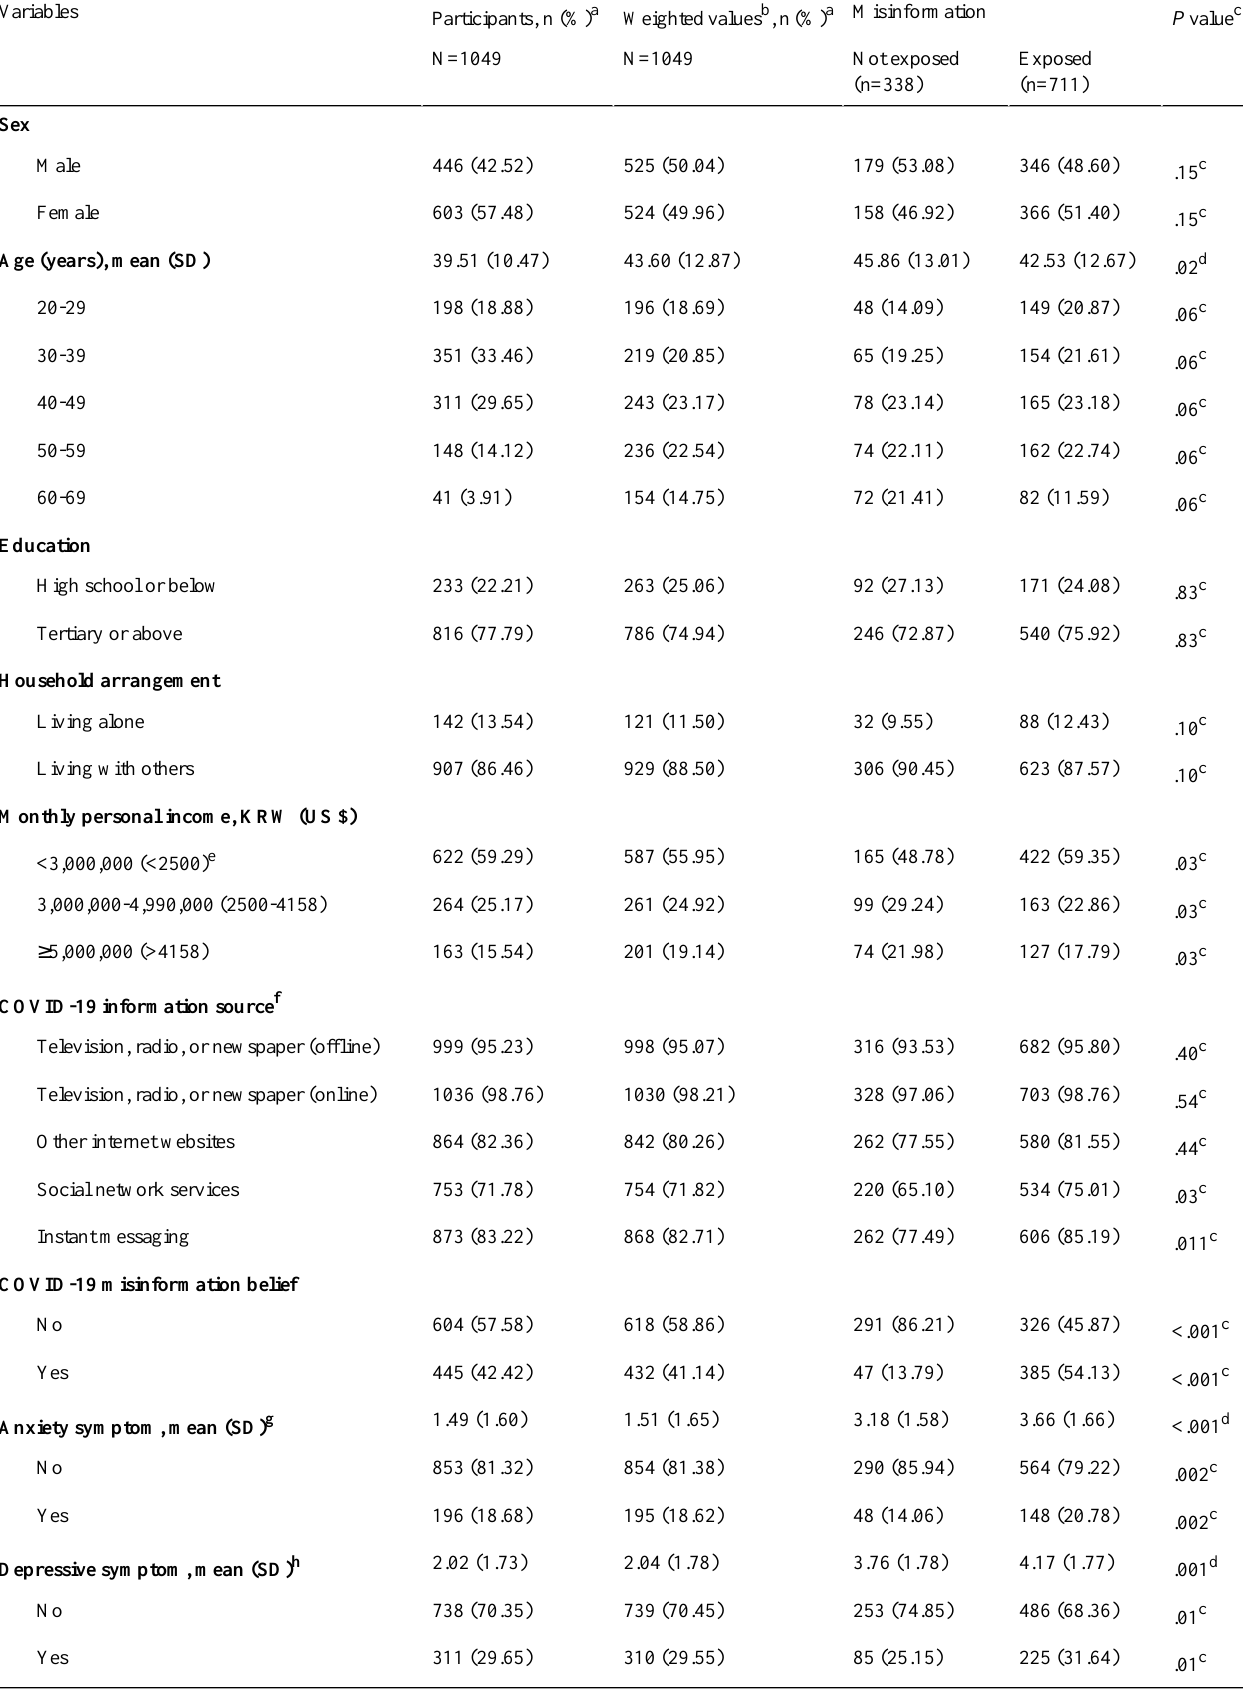
Table 1. Characteristics of COVID-19 misinformation exposure by respondents’ demographics, and sociobehavioral and psychological symptoms